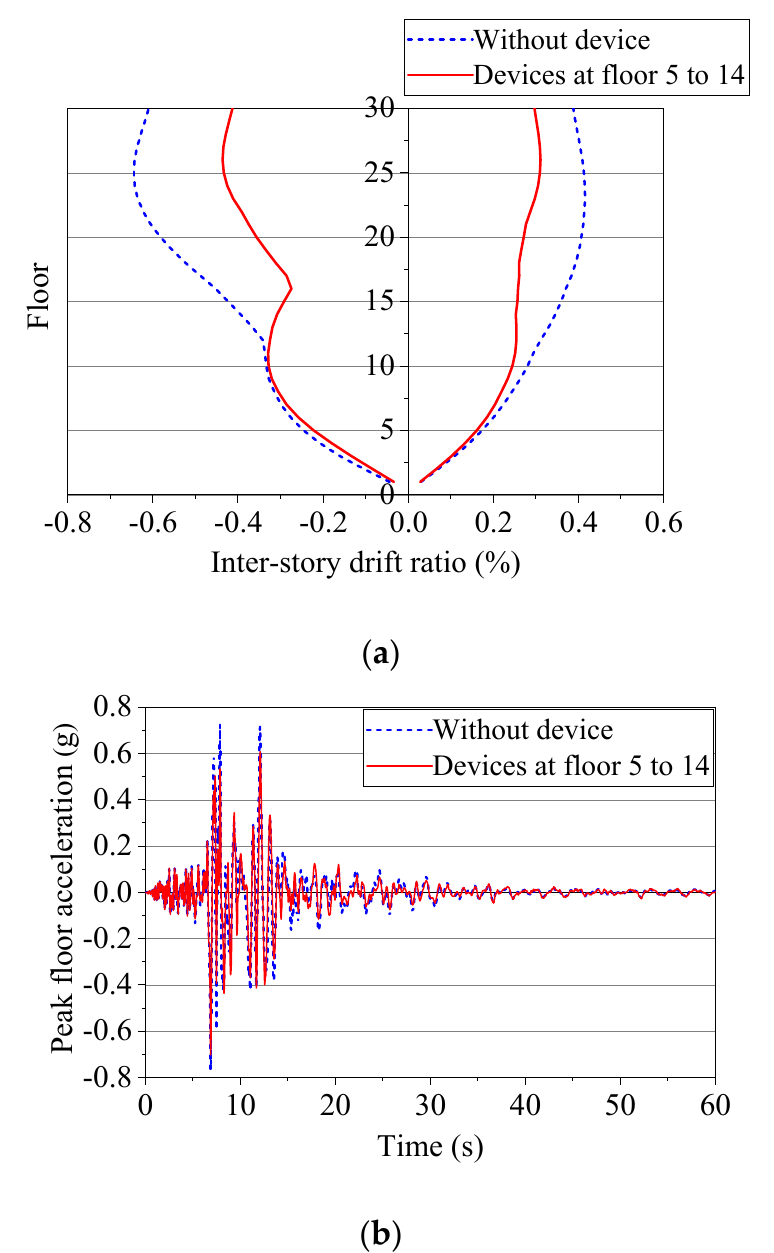
Figure 22. Behavior of structures: ( a ) Inter-story drift and ( b ) Floor acceleration on 30th floor: devices on floors 21 to 30; ( c ) Inter-story drift and ( d ) Floor acceleration on 30th floor: devices on floors 15 to 24.